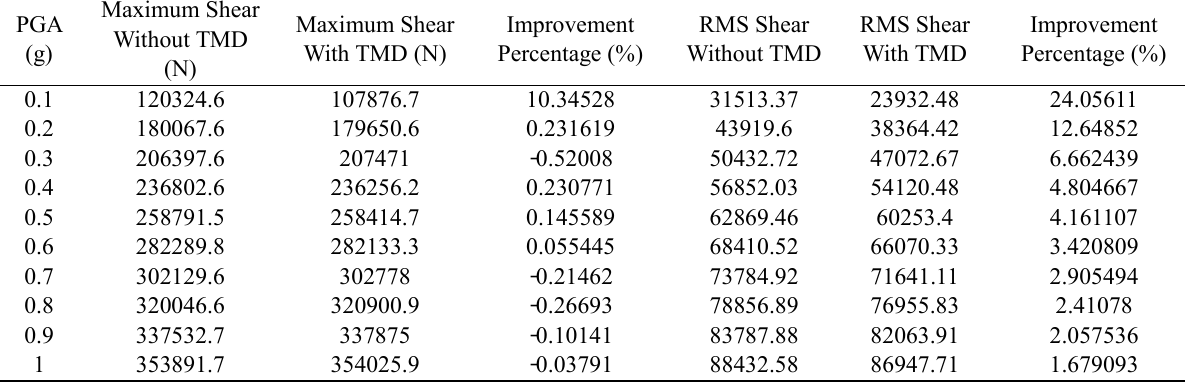
Average Maximum value and RMS of Base Stress and of the Roof of an Irregular Mass Structure, on the first floor, based on Far-Field